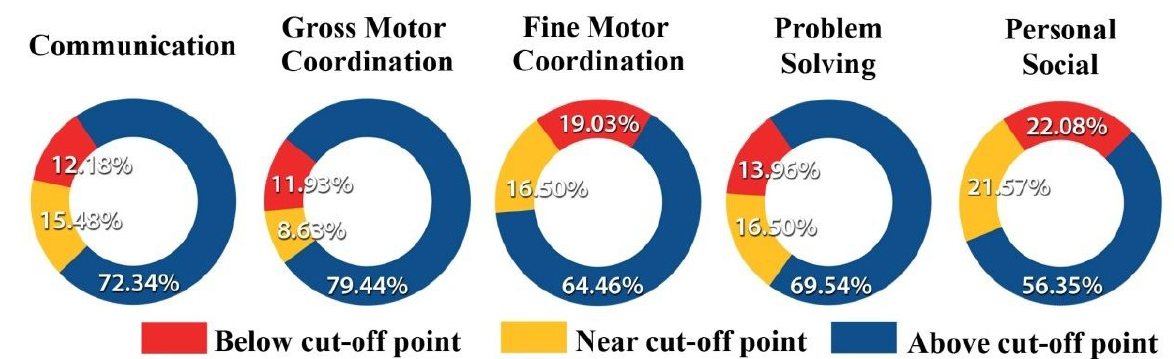
Figure 2. Performance by